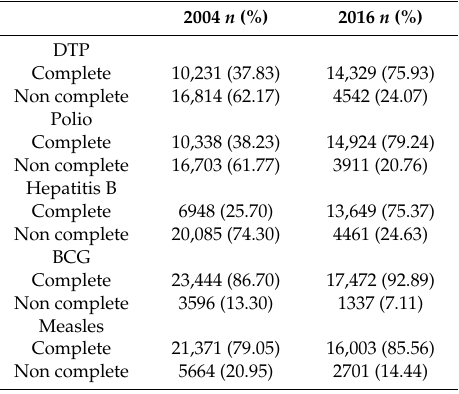
Table 3. Immunization status for each immunization type in 2004 and